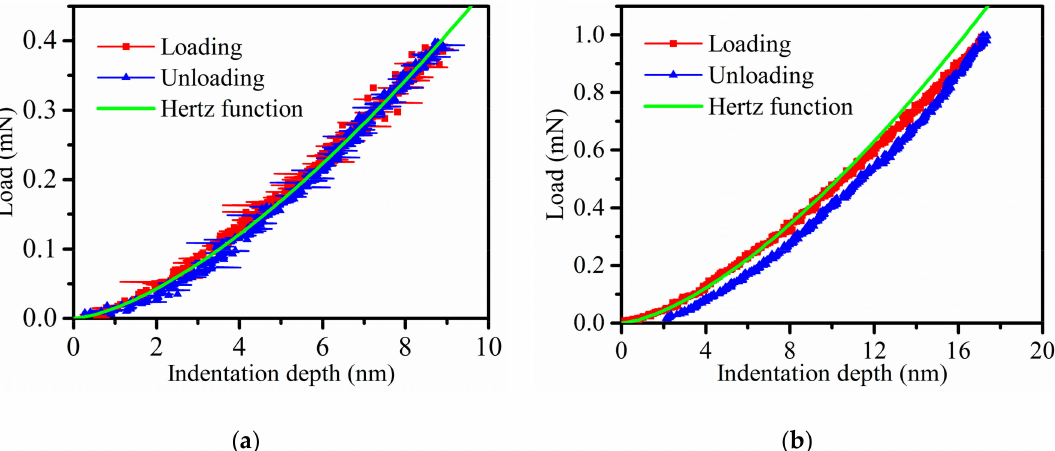
Figure 5. They are load versus indentation depth curves for elastic deformation and plastic deformation of indentations: ( a ) the elastic deformation (maximum load of 0.4 mN) and ( b ) the plastic deformation (maximum load of 1